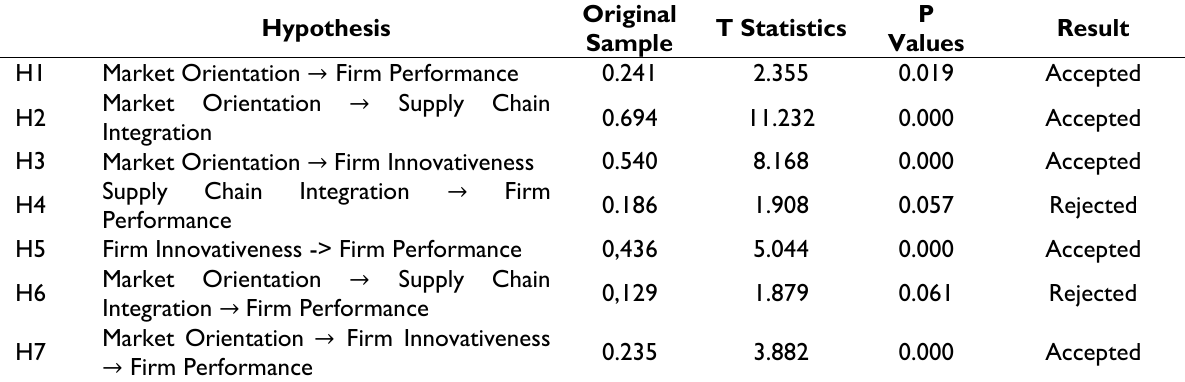
Table 5. Hypothesis Testing